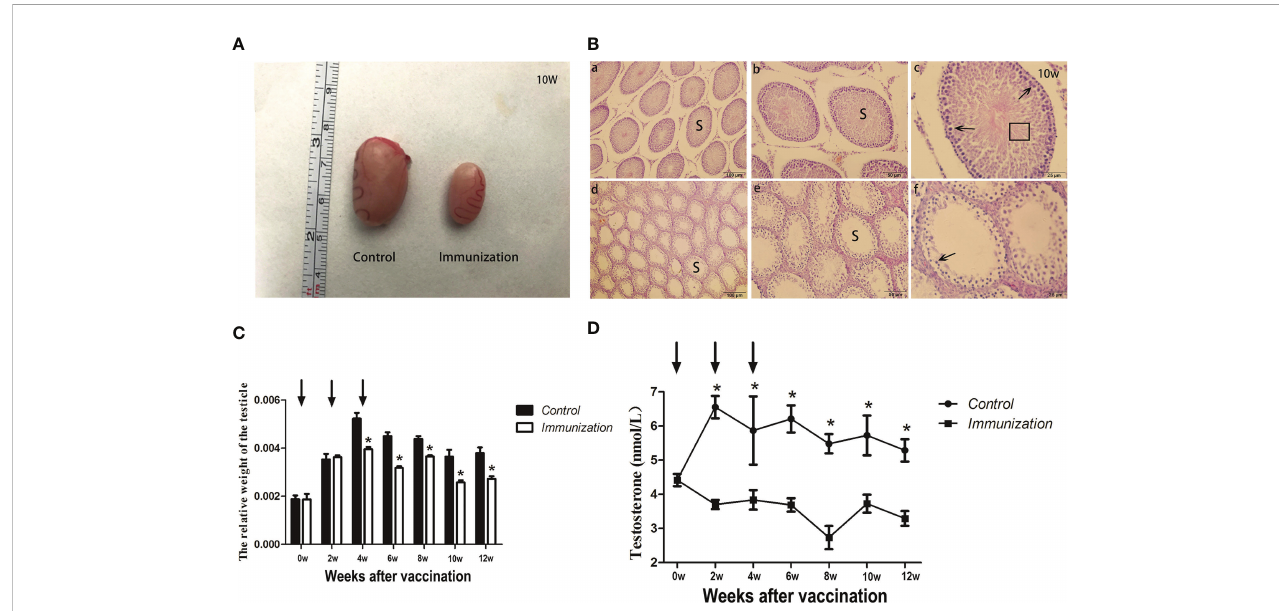
FIGURE 2 (A) Images of testicles of the gonadotropin-releasing hormone (GnRH) immunization and control groups from 10 Week rats after fi rst immunization. (B) Histopathological observation of testes samples from the control group (a, b, c), and the gonadotropin-releasing hormone (GnRH) immunization group (d, e, f) at 10 weeks after fi rst immunizaton. (a-c) and (d-f) represents different magni fi cations (100, 200, and 400 times, respectively). S indicates seminiferous tubules; Sperm cells at various stages (arrows), and spermatozoa (square area) are indicated. (C) Mean ( ± SEM) the relative weight of the testicle in gonadotropin-releasing hormone (GnRH) immunization group (n=35) and control group (n=35). Arrows indicate the primary vaccination and subsequent boosters. * Indicates a signi fi cant difference ( P < 0.05). (D) Mean (± SEM) of the serum testosterone concentration in the gonadotropin- releasing hormone (GnRH) immunization group (n =35) and control group (n = 35). The ordinate is the concentration of testosterone. The abscissa is the age of weeks after fi rst immunization and arrows indicate the primary vaccination and subsequent boosters. The testosterone levels were detected using an enzyme-linked immunosorbent assay (ELISA). * Indicates a signi fi cant difference ( P < 0.05).